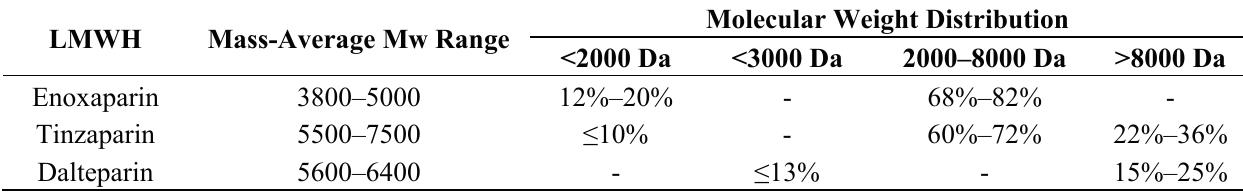
Table 5. Mass-average Mw range and molecular weight distribution of the three commercial LMWH as reported in EP monograph